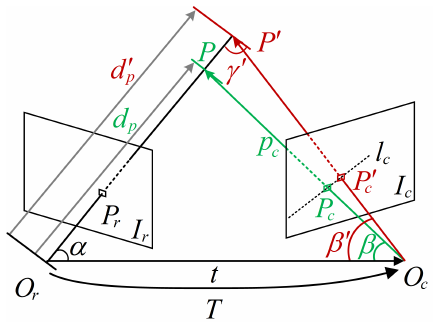
Figure 5. Depth estimation based on direct